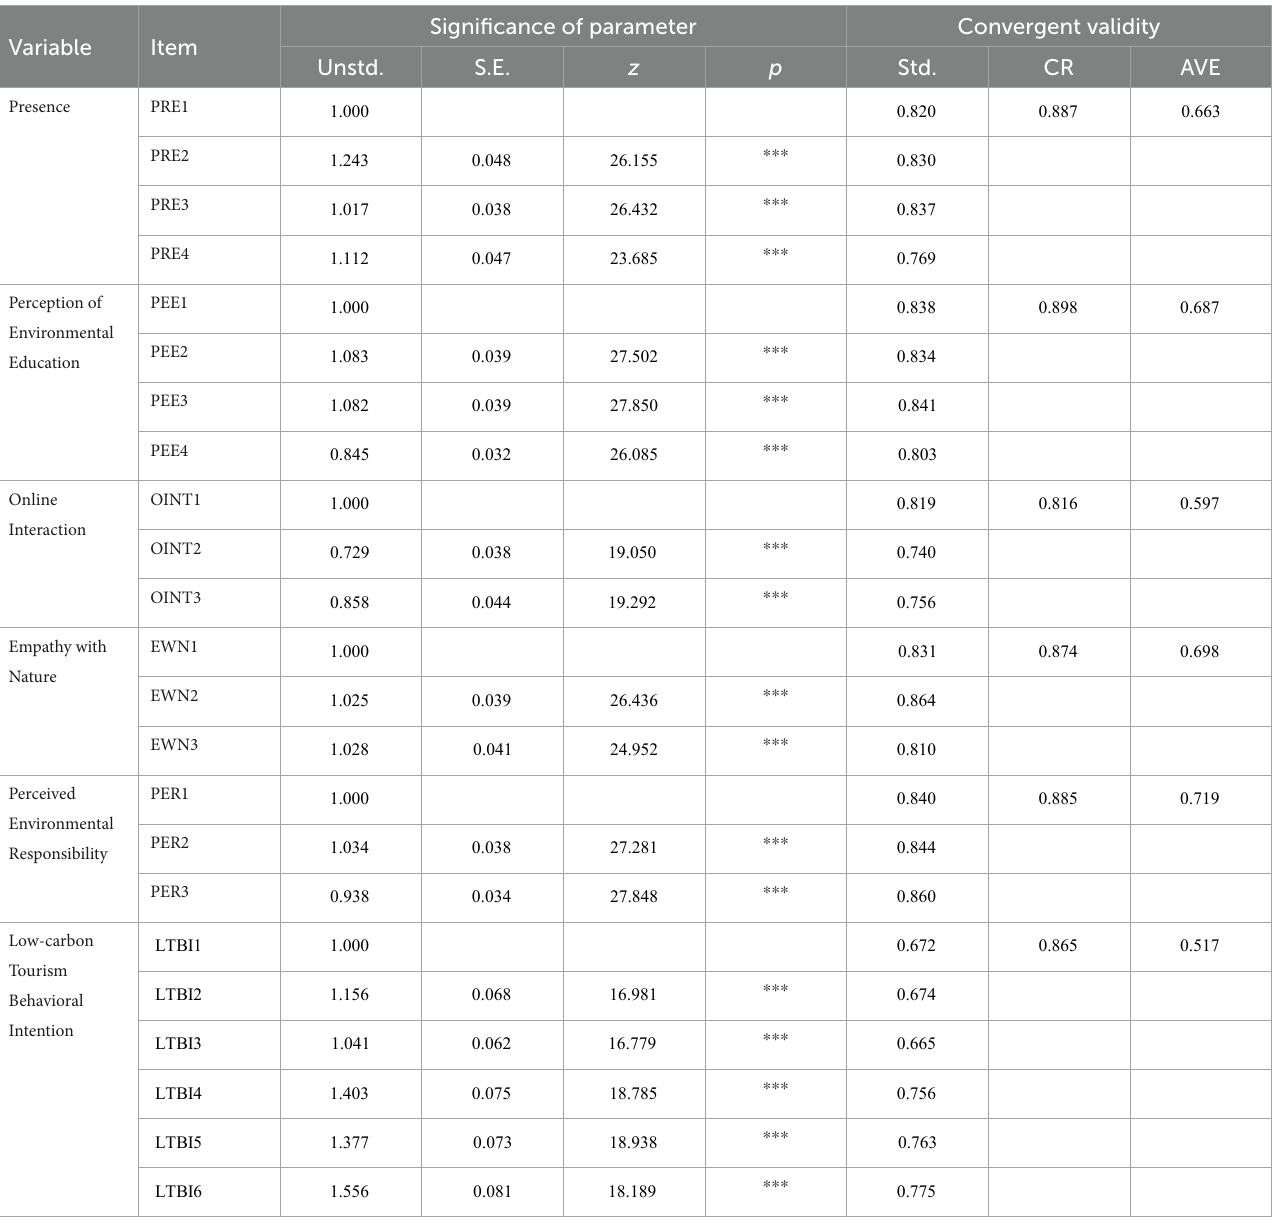
TABLE 2 Confirmatory factor analysis.